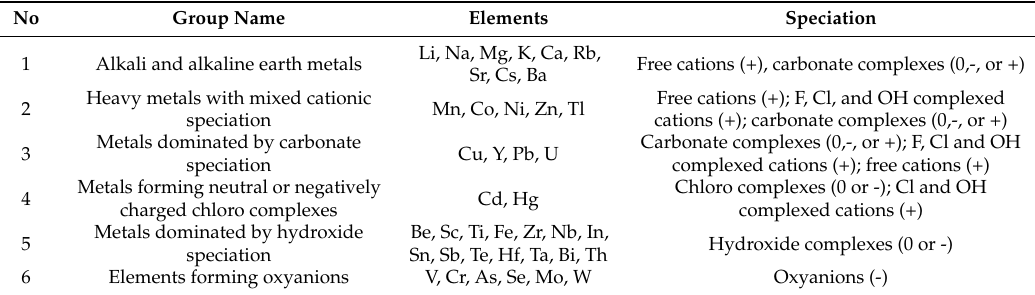
Table 6. Inorganic speciation of elements in oxic seawater